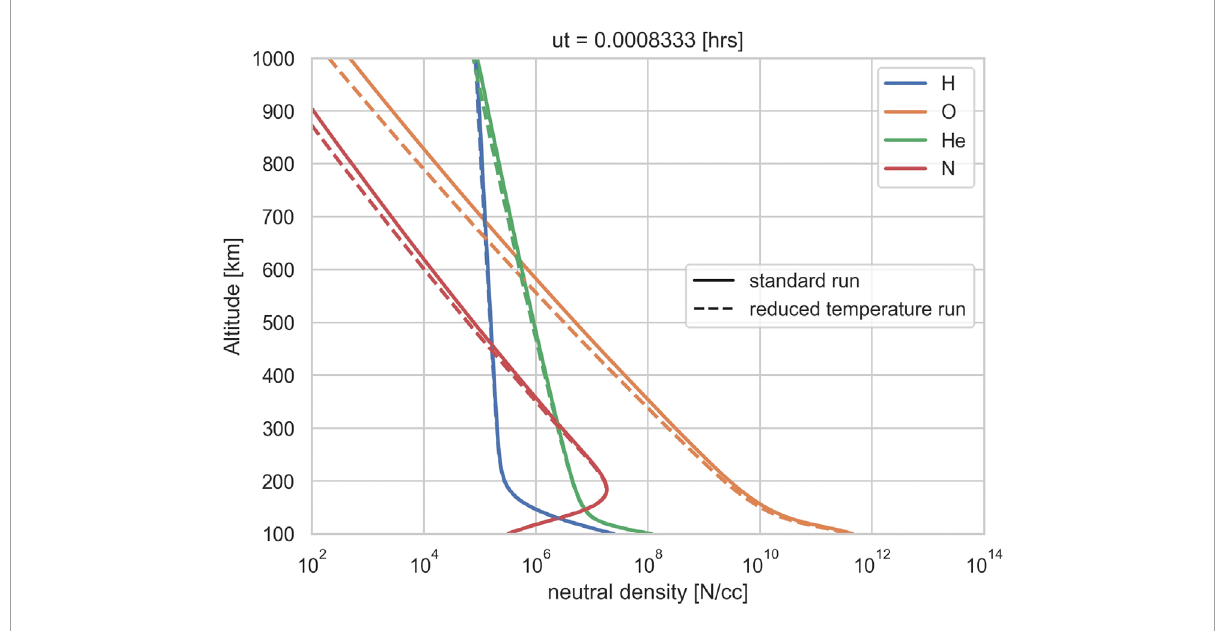
FIGURE 2 Modification of the NRLMSISe exospheric